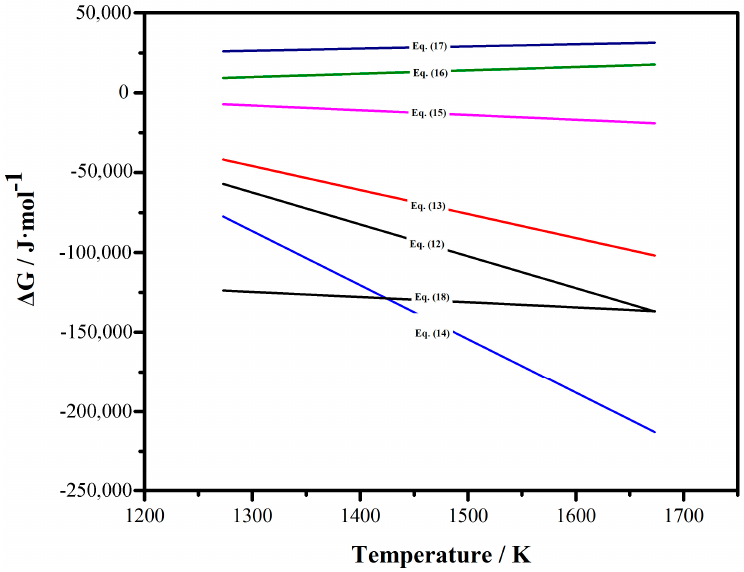
Figure 6. The thermodynamic lines of each reduction reaction.